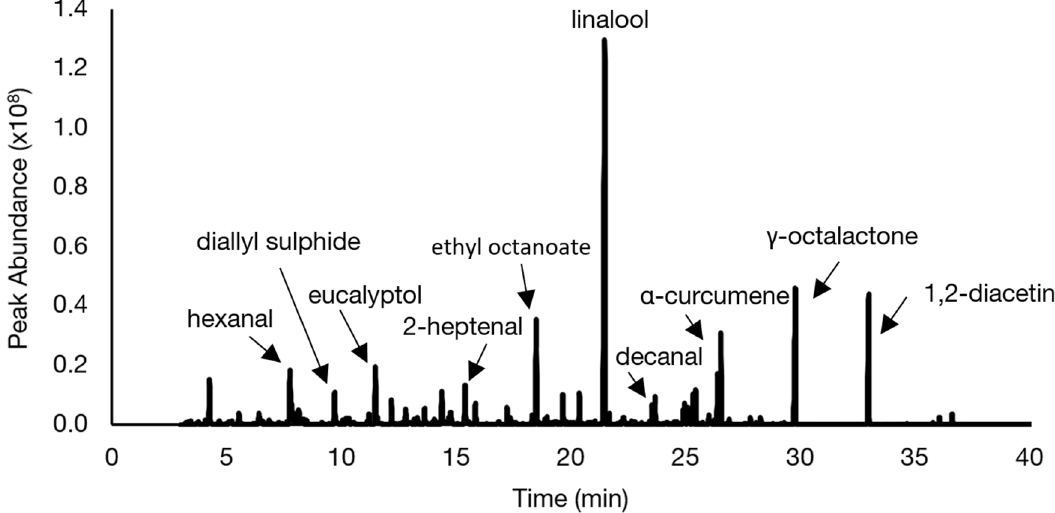
Figure 6. Representative total ion chromatogram of the headspace volatile fraction of the reference soup containing potato starch.